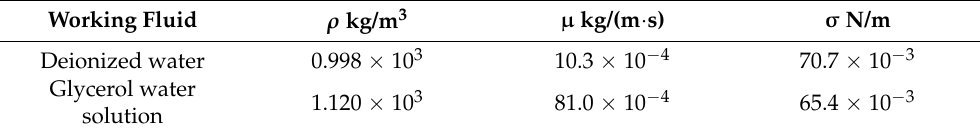
Table 1. Working fluid